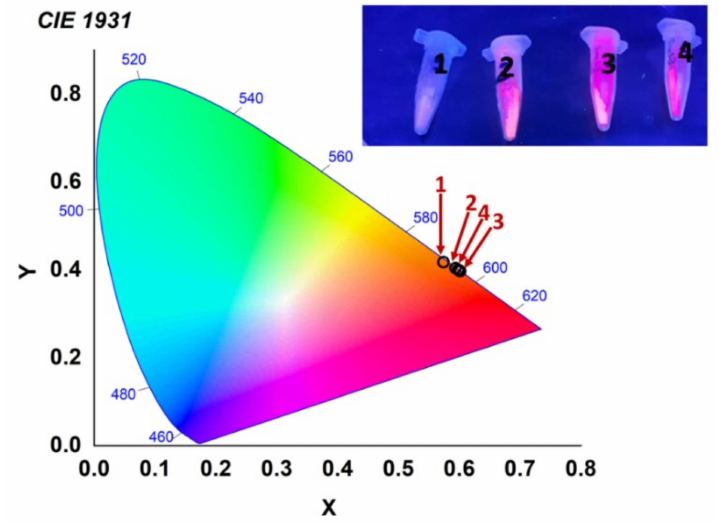
Figure 4. CIE diagram of the emission color of compounds 1 – 4 . Inset shows the emission of compounds under UV